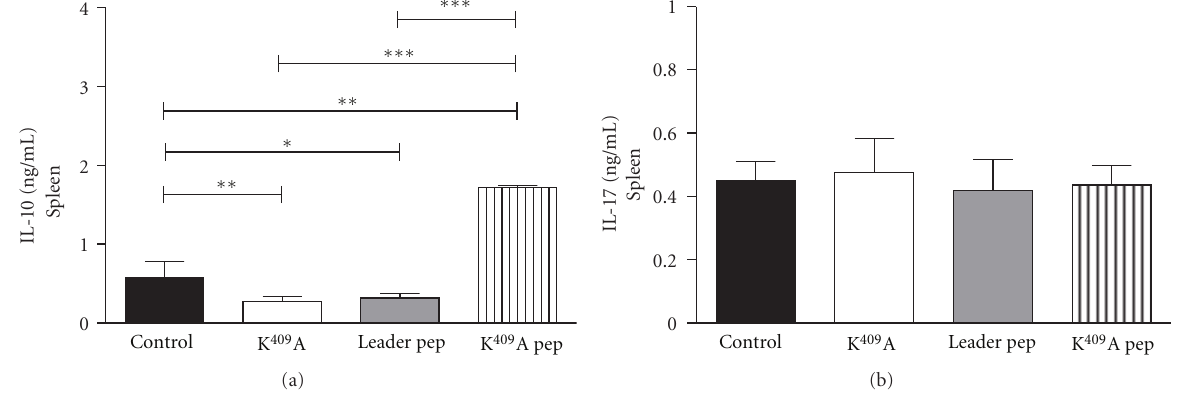
Figure 4: Analyses of IL-10 and IL-17 levels. Spleen cells from K 409 A, Leader pep, and K 409 A pep inoculated, or control mice were harvested at day 21 and stimulated in vitro with 30mg/mL IRBP. After 72 hours, IL-10 (a) and IL-17 (b) levels were determined by ELISA. Results are expressed as mean ± SD. ∗∗ P < 0 . 01: control versus K 409 A (A); ∗ P < 0 . 05: control versus Leader pep (A); ∗∗ P < 0 . 01: control versus K 409 A pep (A); ∗∗∗ P < 0 . 001: K 409 A versus K 409 A pep (A); ∗∗∗ P < 0 . 001: Leader pep versus K 409 A pep